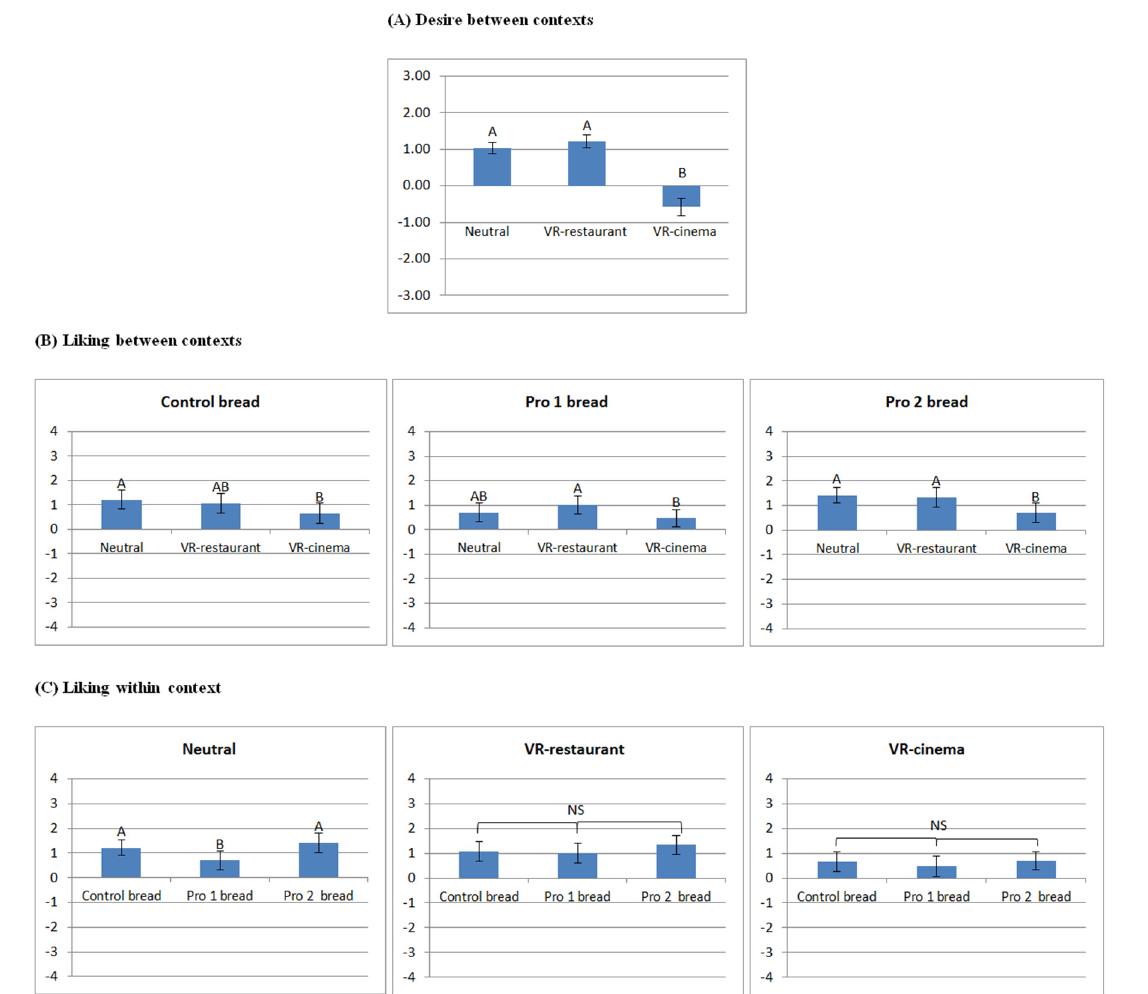
Figure 5. Participants’ stated desire (mean ± SEM) for the rye bread across three contexts ( A ) and comparisons of liking scores (mean ± SEM) for rye breads between ( B ) and within contexts ( C ). Different letters indicate significant differences at p < 0.05. NS = non-significant. Control bread = rye bread without protein enrichment. Pro 1 bread = rye bread enriched with 7% whey protein isolate.